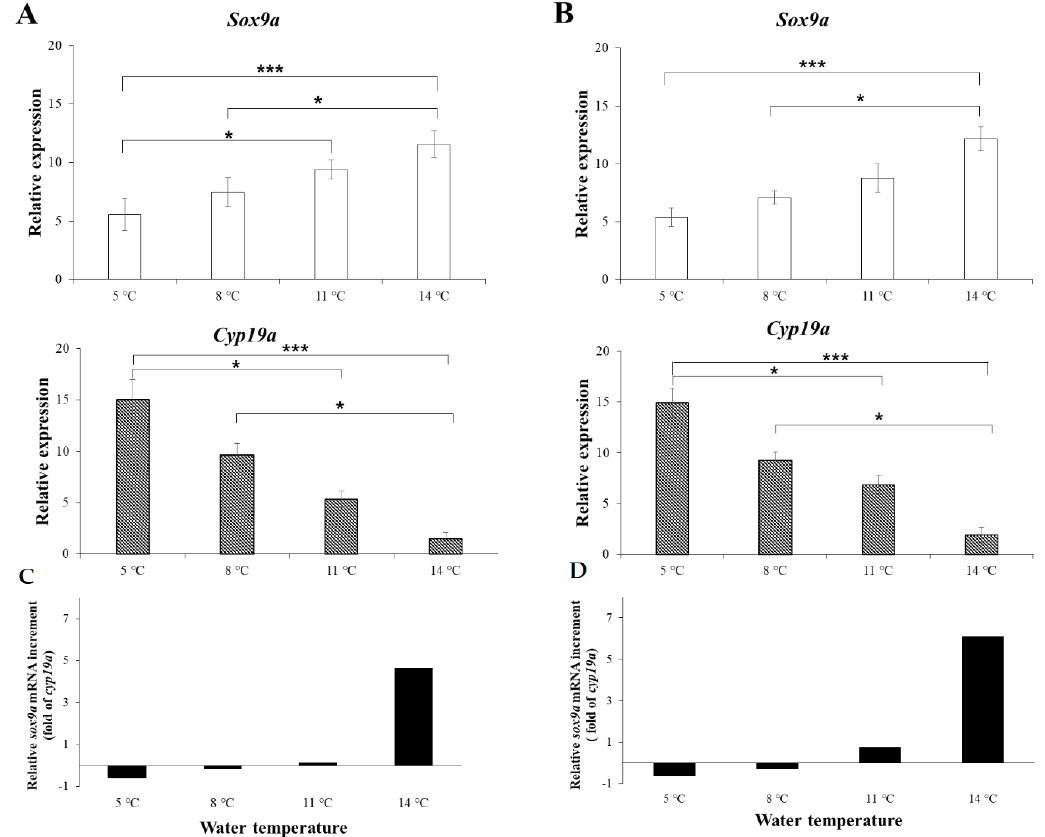
Figure 3. ( A ) Sox9a and cyp19a mRNA expression levels in the embryos at different